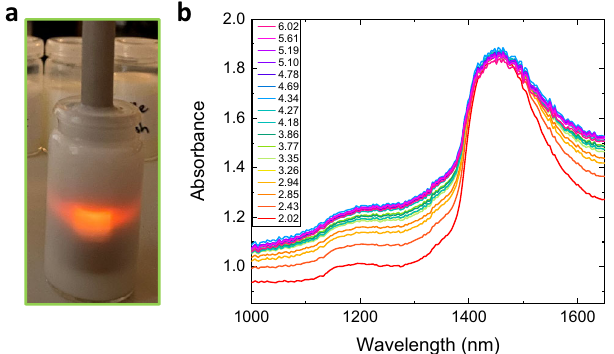
Fig. 3 Spectral sensing of milk samples. a Trans fl ection probe inserted in a milk sample. b Absorbance of 17 milk samples with different fat wt%, measured using a commercial